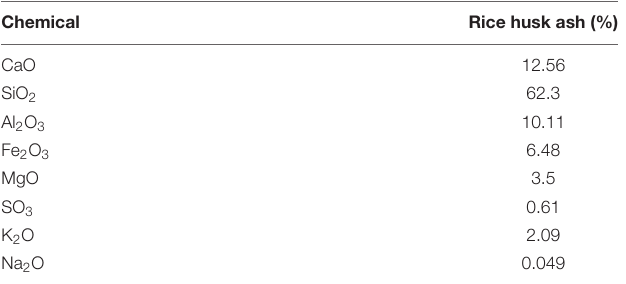
TABLE 4 | Chemical composition of rice husk ash. TABLE 5 | Physical property of superplasticizer.